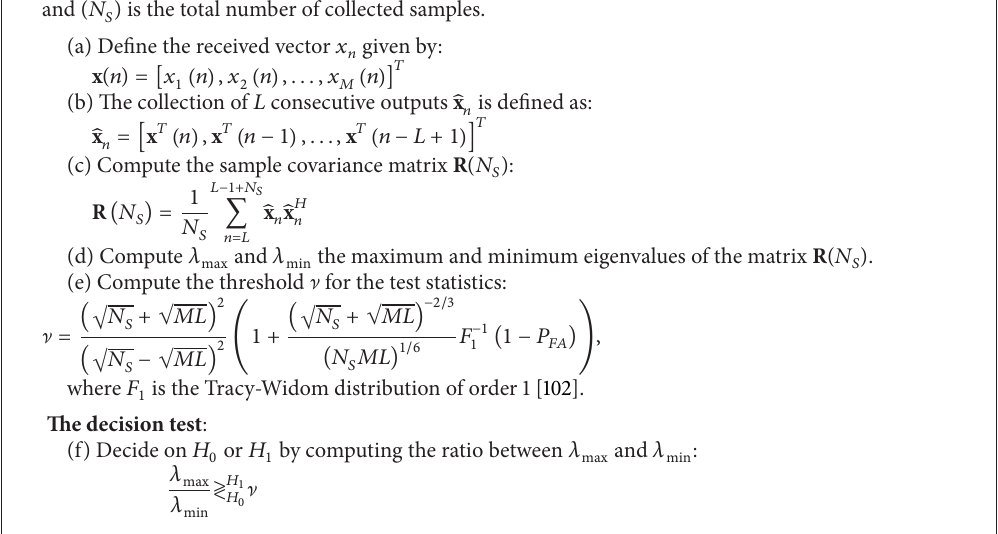
Algorithm 1: Steps of the MME